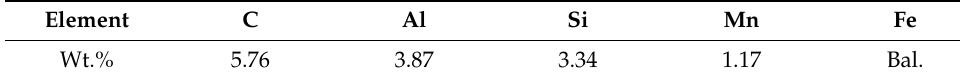
Table 1. Chemical composition of the iron-based powders.